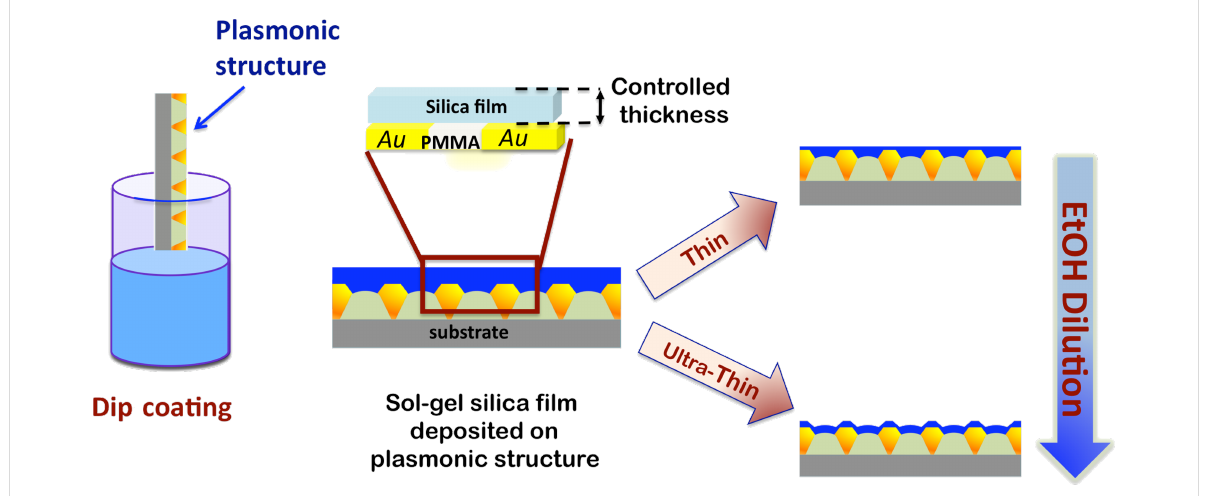
Figure 4: Tunable-thickness silica layer deposition onto plasmonic structures by dip coating. The thickness control of the layer is achieved by control- ling pH, sol aging, withdrawal speed and the EtOH concentration.